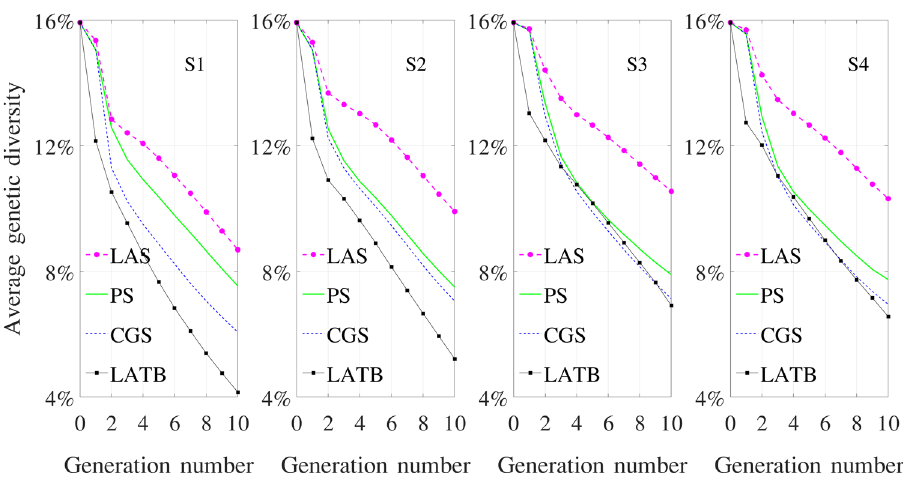
Figure 8. Genetic diversity over ten generations, averaged over 500 independent simulation